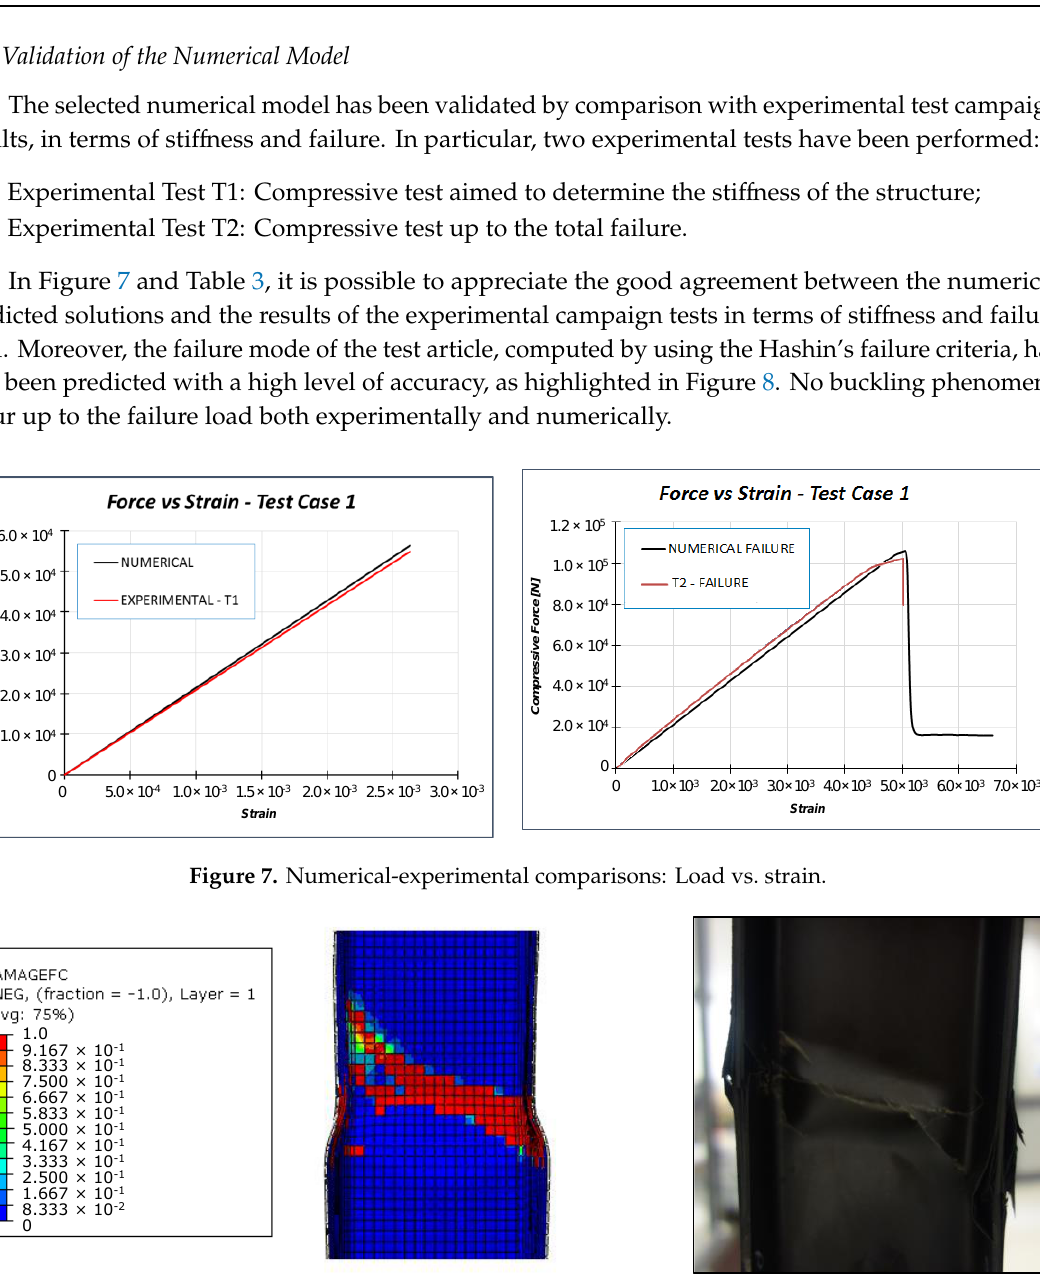
Figure 8. Numerical-experimental comparisons: Failures.